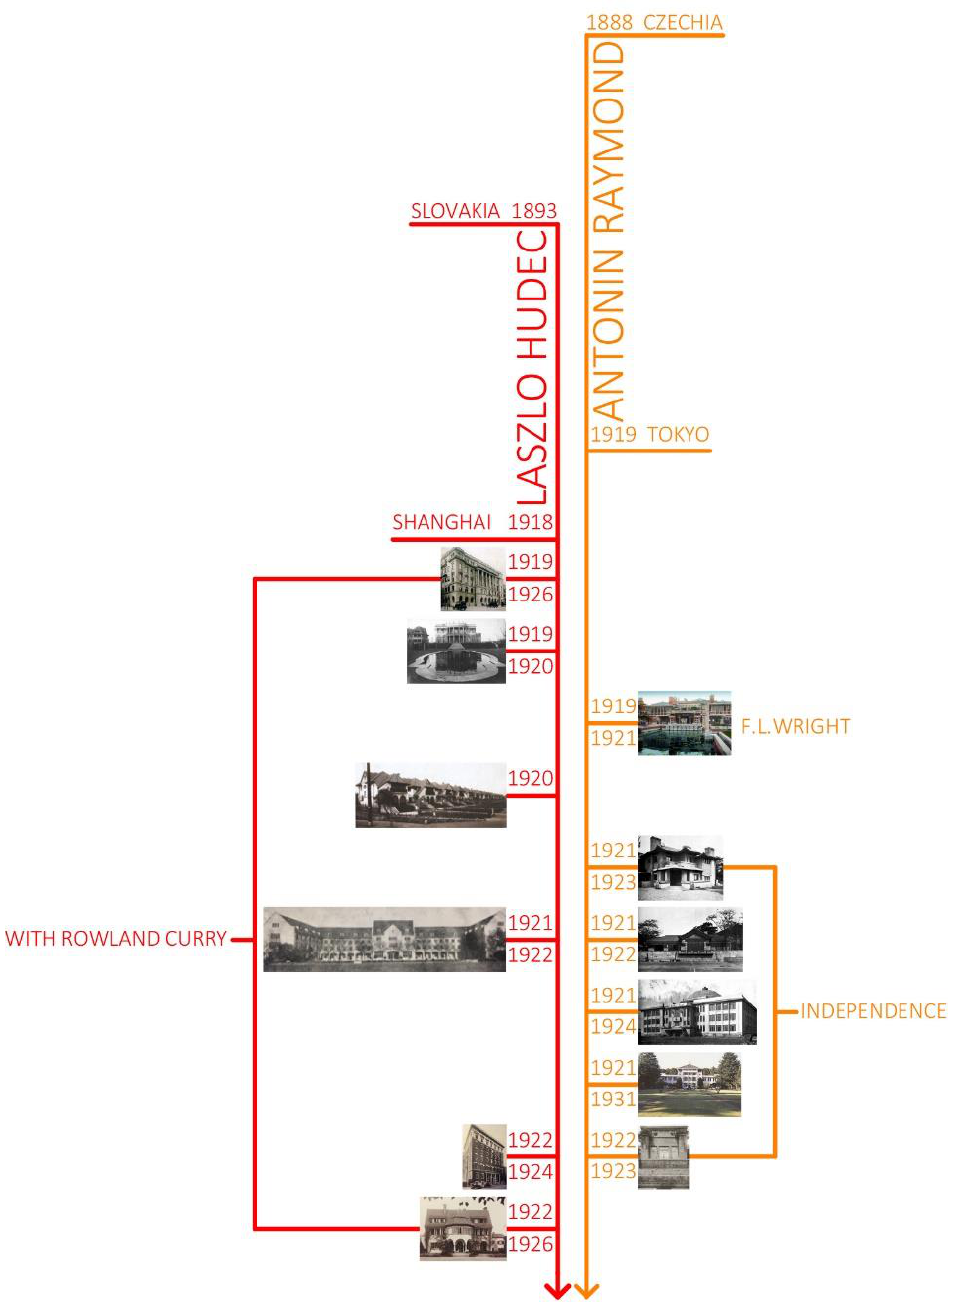
Figure 2. Timeline 01 — Hudec and Raymond comparative designs.